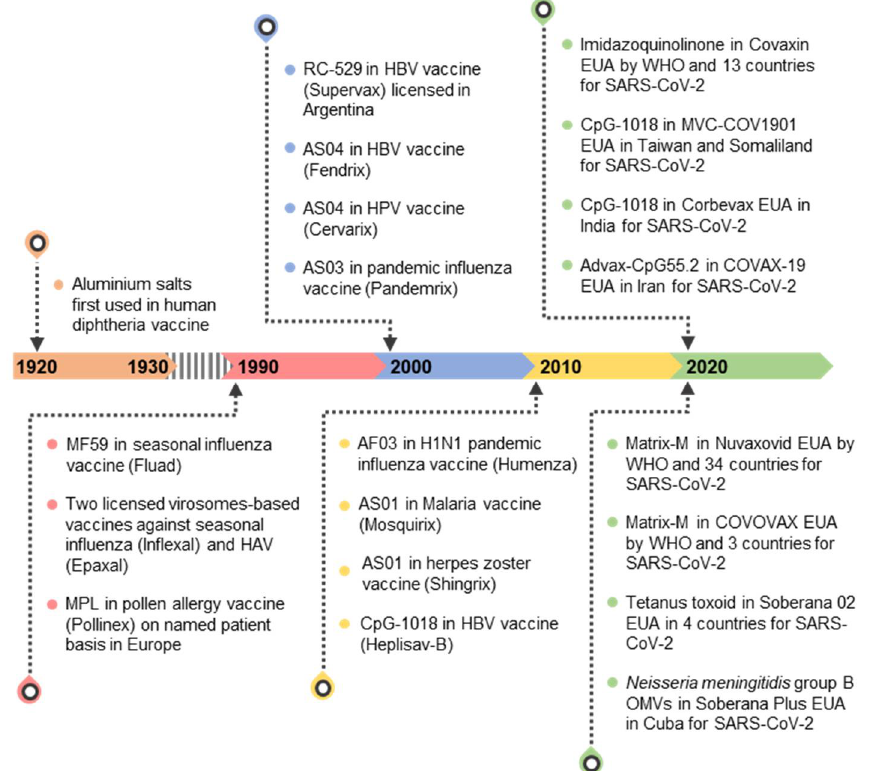
Figure 1. A timeline of adjuvant development and vaccine licensing. The year the adjuvant was used in licensed vaccines or emergency use authorized (EUA) vaccines is shown. AS, adjuvant system; MPL, monophosphoryl lipid A; HAV, hepatitis A virus; HBV, hepatitis B virus; HPV, human papillomavirus; WHO, world health organization; OMVs, outer membrane vesicles.